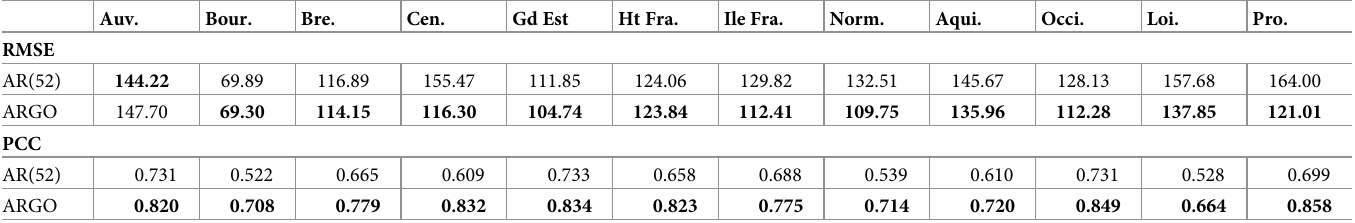
Table 4. Real time estimate—RMSE and PCC for ARGO models including only historical data (AR(52)) and only climatic data, for the period starting from January 2015 to March 2017. Auv. Bour. Bre. Cen. Gd Est Ht Fra. Ile Fra. Norm. Aqui. Occi. Loi. Pro. RMSE AR(52) 59.02 ARGO 57.89 35.65